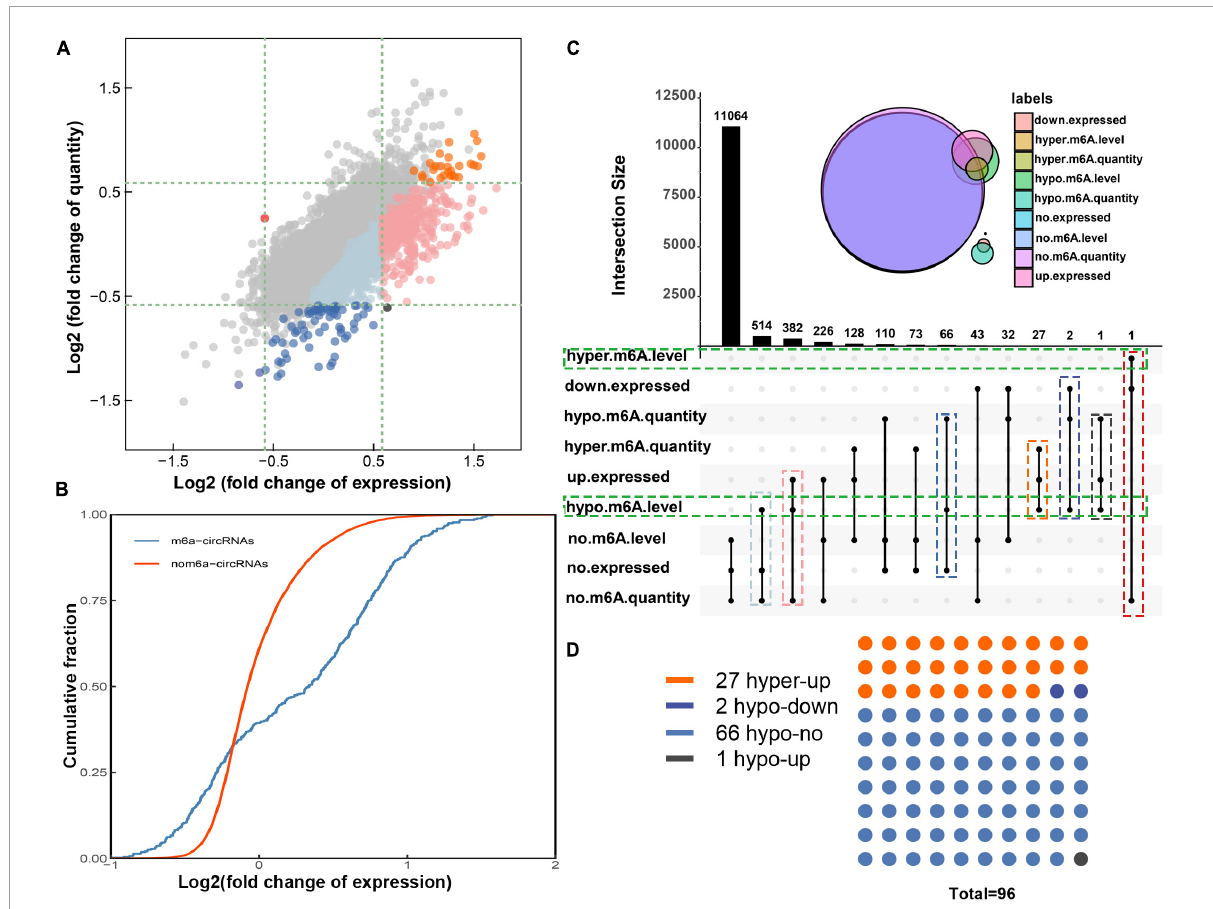
FIGURE3 Joint analysis of m 6 A methylation and expression patterns of circRNAs in morphine tolerance. (A) The nine-quadrant graph shows the relationship between m 6 A quantity and the expression of circRNAs. (B) Cumulative distribution of circRNAs expression between MT group and NS group for m 6 A-circRNAs (blue) and non-m 6 A- circRNAs (red). (C) The upset diagram shows the m 6 A quantity, expression, and m 6 A level of circRNAs and presents 14 different methylation and expression patterns of circRNAs. (D) The dot plot shows the distribution of 96 circRNA with both dysregulated m 6 A quantity and m 6 A level. The orange dots (hyper-up) show 27 circRNAs were hypermethylated and up-expressed, 2 navy blue dots (hypo-down) represent circRNAs were hypomethylated and down-expressed; 1 black dot (hypo-up) represent circRNA were hypomethylated and up-expressed; the light blue dots (hypo-no) represent 66 circRNAs with decreased m6A modification quantity but unchanged expression